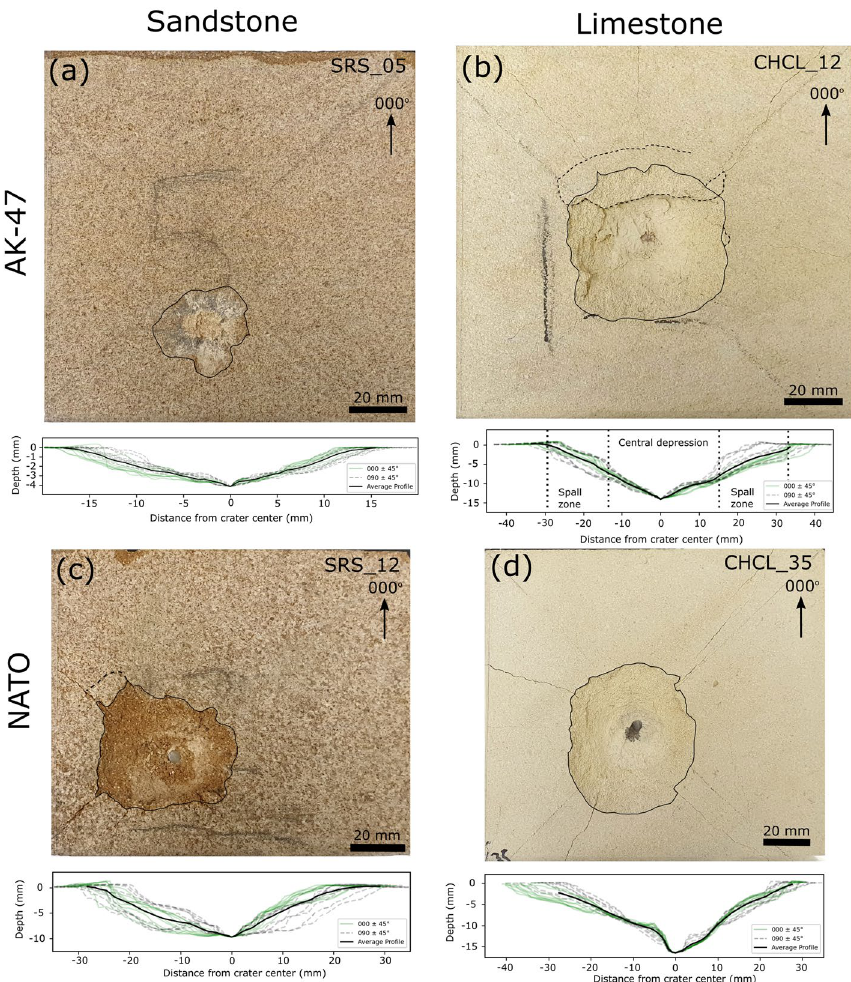
Figure 2. Photographs of impact craters and summary of 18 cross section profiles caused by 7.62x 39 mm (AK-47) ( a , b ) and 5.56x 45 mm NATO (NATO) ( c , d ) projectiles. An azimuth direction of 000 ◦ points towards the top edge of the target block in its firing position. Profiles oriented between 000 ◦ ± 045 ◦ are coloured green, while profiles oriented 45 ◦ either side of 090 ◦ are dashed grey. The crater outline is marked with a solid black line and incipient spall fragments by a dashed black line. Fractures can be seen radiating from the impact crater to the edge of the target block. The steel tip of the NATO projectile can be seen embedded in the target block ( c , d